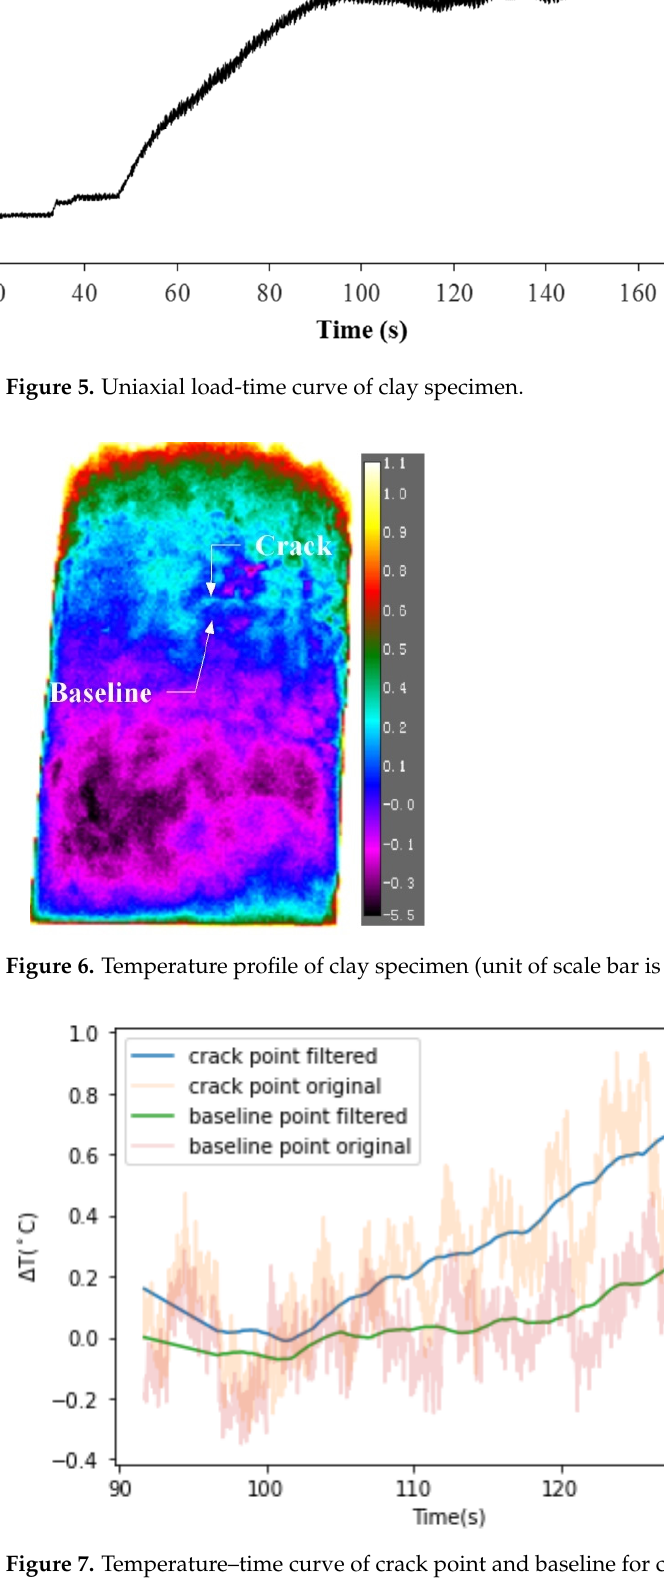
Figure 8. Temperature profile along a measurement line approximately perpendicular to the crack (the position of the measurement line is marked on the temperature profile attached on the top left). 3.2. Bulge Effect in Frozen Sand Although there was no individual crack observed in the sand case, as the frozen sand specimen was compressed, the expansion in the radial direction, which we termed bulge, became significantly visible after yield and the observation can also be correlated to temperature variations. The temperature of three representative points located at the upper part (U.), lower left part (L.L), lower right part (L.R), and the average temperature of a square area (S.) were selected to demonstrate the effect of the bulge on temperature. The locations are indicated in Figure 9. In Figure 9, temperatures are mostly above 0 °C as the surface of the specimen was covered by water instead of ice. The ambient air temper- ature was around 30 °C. The ice on the top of the specimen melted immediately after con- tact between the specimen and upper platen of the compression machine. Due to gravita- tional effects, the water subsequently ran off downwards onto the specimen surface. Alt- hough the specimen was completely frozen initially, certain parts melted during the com- pression test. The same observation was made for the clay specimen and gravel specimen.